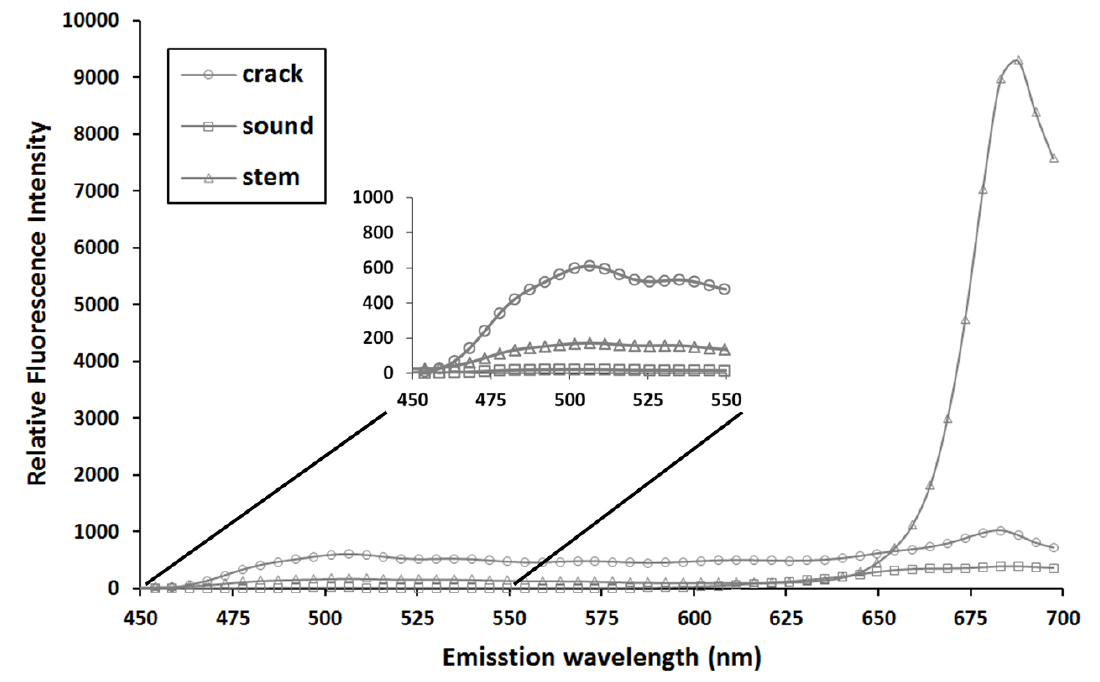
Figure 5. Mean fluorescence emission spectra of sound surface, defect area, stem area in hyperspectral image of cherry tomatoes upon excitation by 410 nm light